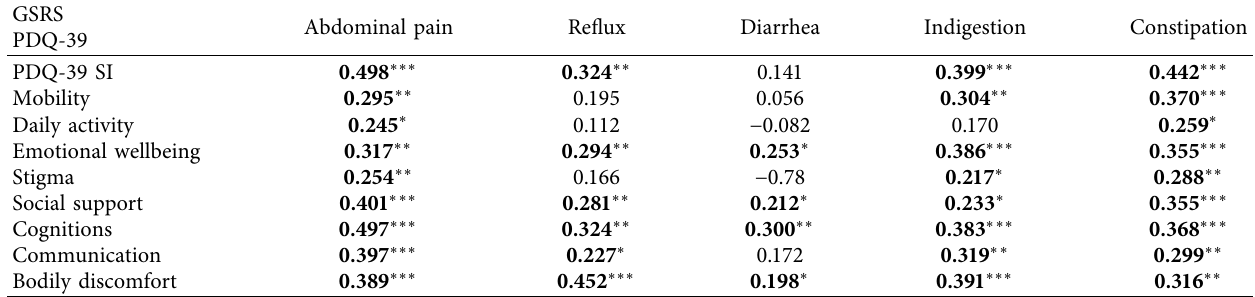
Table 7: Spearman correlations (pairwise) of PDQ-39 scale and its domains with GSRS domains. GSRS